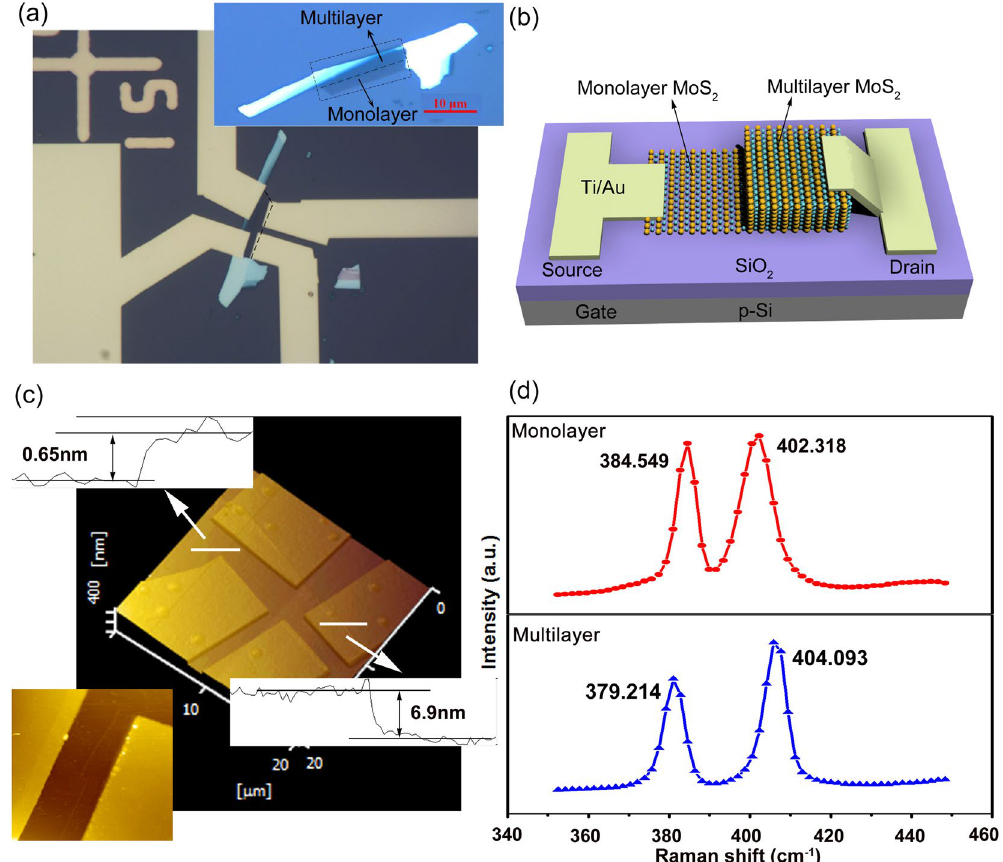
Figure 1. ( a ) The optical microscopy images of MoS 2 before and after metal deposition. ( b ) The schematic of the photodetector based on multilayer/monolayer